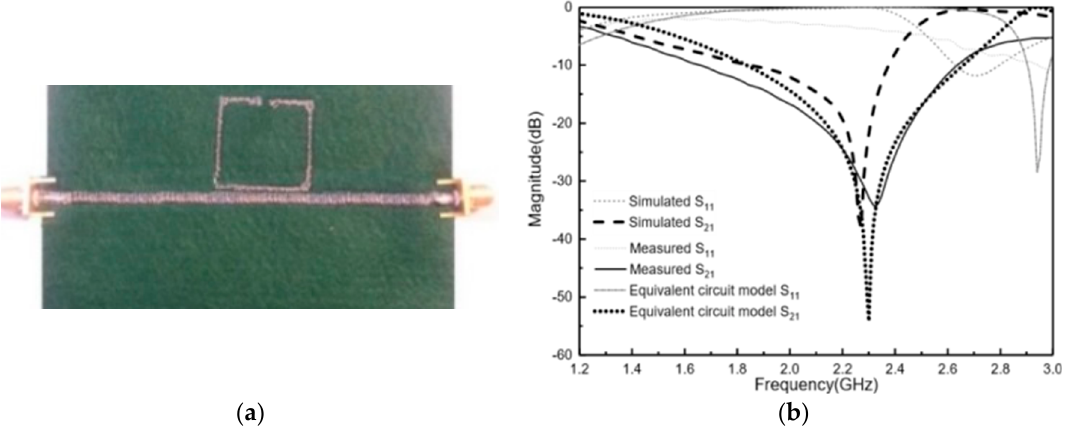
Figure 3. ( a ) Photograph of the embroidered design with satin pattern with 60 % density (top view) and ground implemented with WE-CF adhesive copper. ( b ) S-parameter responses of the electromagnetic (EM) simulation, equivalent circuit model, and measurement of embroidered transmission line loaded with one SRR photograph of the embroidered design.